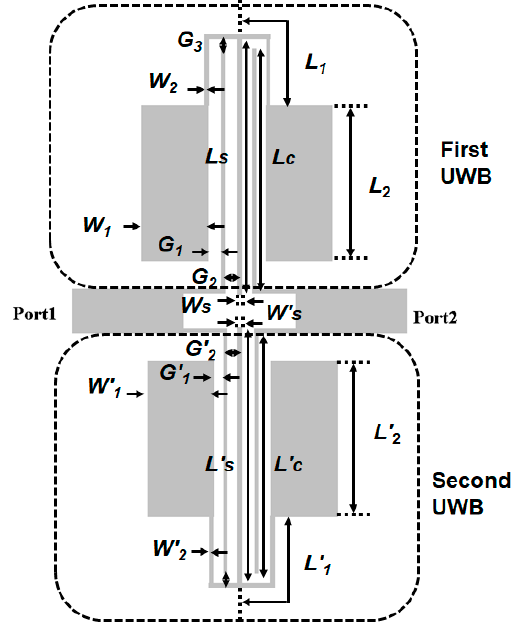
Figure 6. Configuration of the dual UWB BPF.